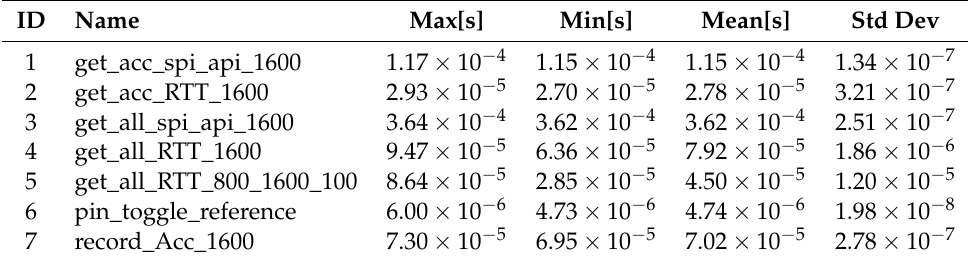
Table 3. Measured timing behavior without optimization (-O0).